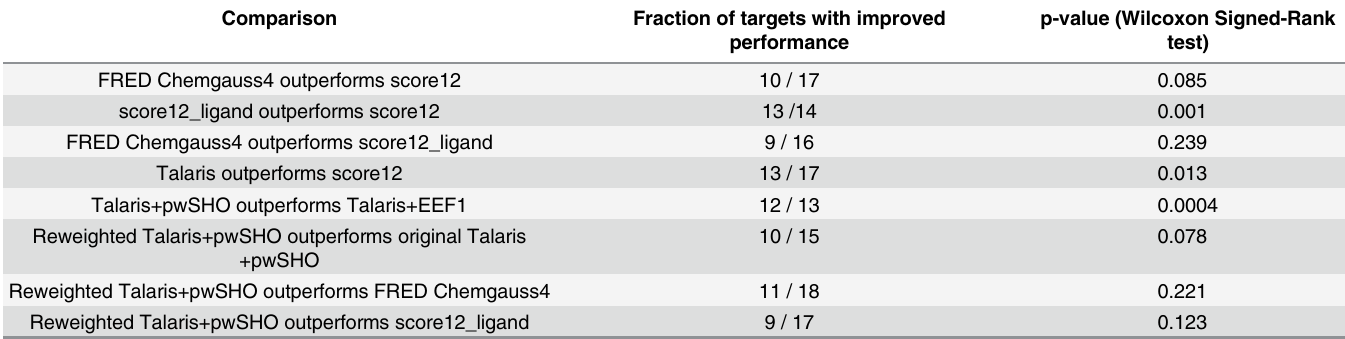
Table 2. Summary of the comparisons made in this study. Among the 18 protein targets used as testcases, those for which the rankings by both scoring functions were within 10% of one another were considered to be “ ties ” . The reported p-values were calculated by applying the Wilcoxon Signed-Rank test to the difference in the log of the rankings, over all testcases. This (non-parametric) statistical test has the advantage that the degree to which a given method “ wins ” each testcase — and not just the number of “ wins ”— is taken into